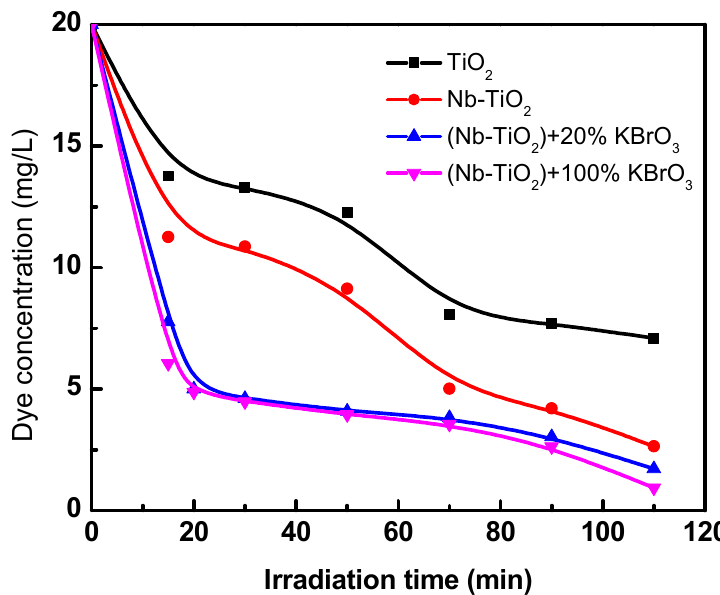
Figure 3. The reduction in the concentration of phenol red dye in the wastewater with irradiation time for pure TiO 2 , Nb-TiO 2 , Nb-TiO 2 /20%KBrO 3, and Nb-TiO 2 /100%KBrO 3 . Note: the dye concentration was 0.9 mg/L after 110 min for Nb-TiO 2 /100%KBrO 3 .